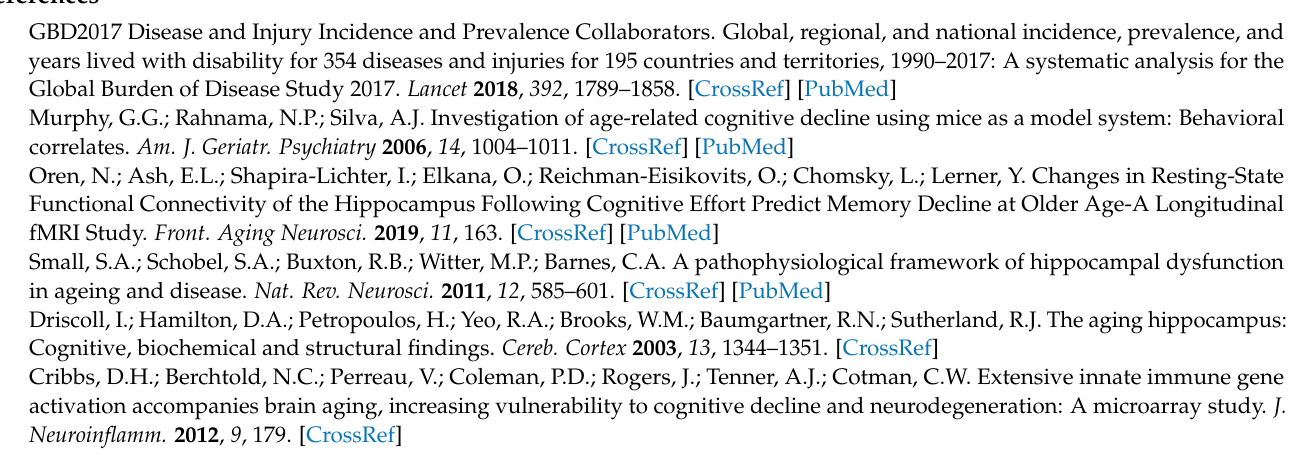
mentary Table S2: DEGs EE; Supplementary Table S3: DEGs Age counter-regulation; Supplementary Table S4:_qPCRValidation; Supplementary Table S5:_effect